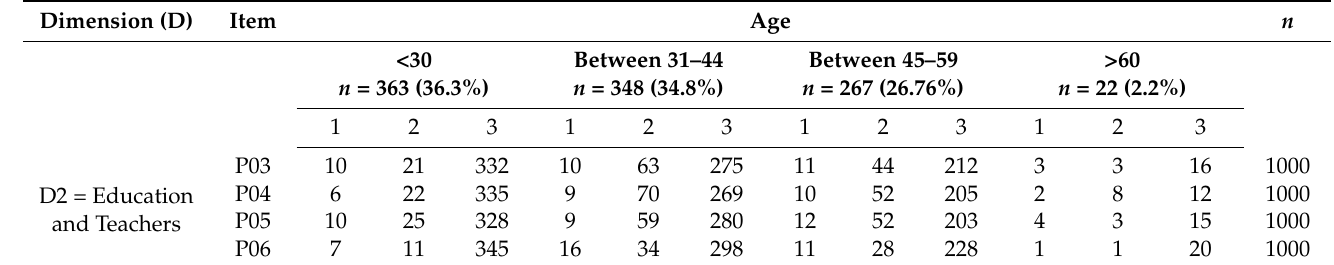
Table 5. Count by age group of the participating sample for dimension D2.